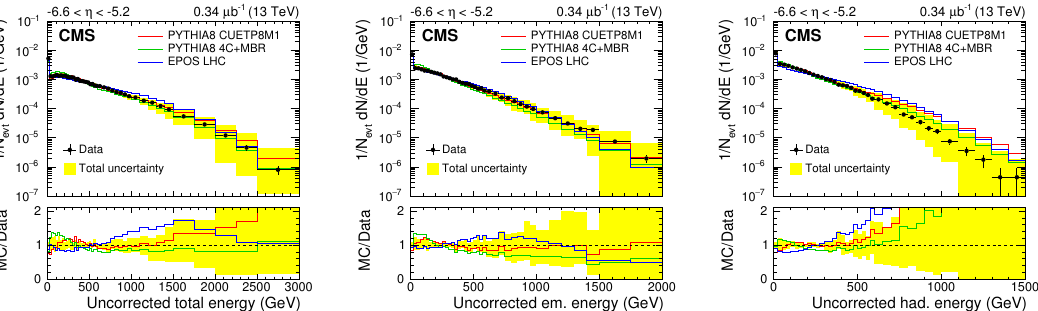
Figure 1 . Spectra of the energy reconstructed in CASTOR, normalized to the number of events that pass the o(cid:15)ine event selection, compared to the detector-level predictions of various event generators. The total energy spectrum is shown in the left panel, the electromagnetic in the middle, and the hadronic in the right. Statistical (systematic) uncertainties are shown with error bars (yellow band, discussed in section 4).